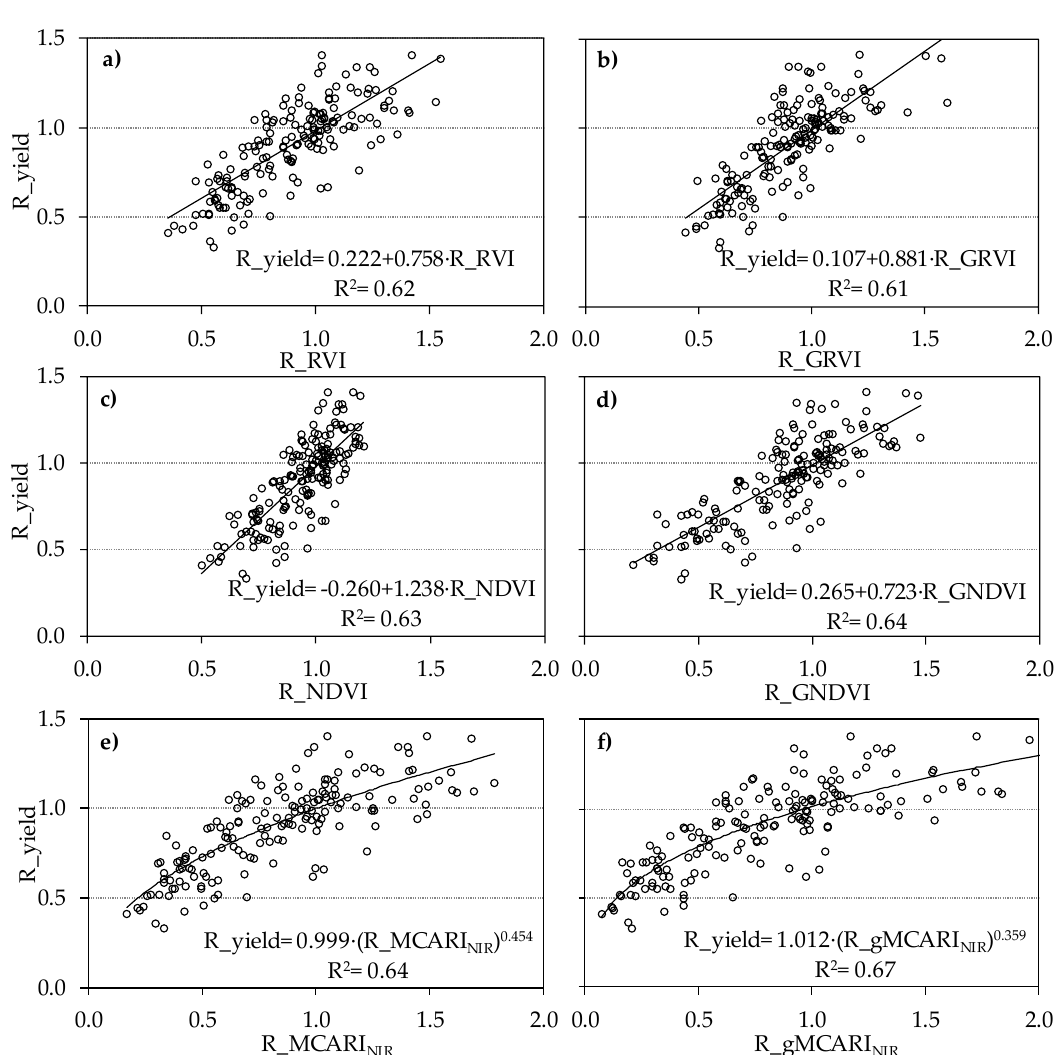
Figure 3. Relationship between R yield and R_VIs (R_RVI (a), R_GRVI (b), R_NDVI (c), R_GNDVI (d), R_MCARI NIR (e), and R_gMCARI NIR (f)) for the pooled data over the two years.